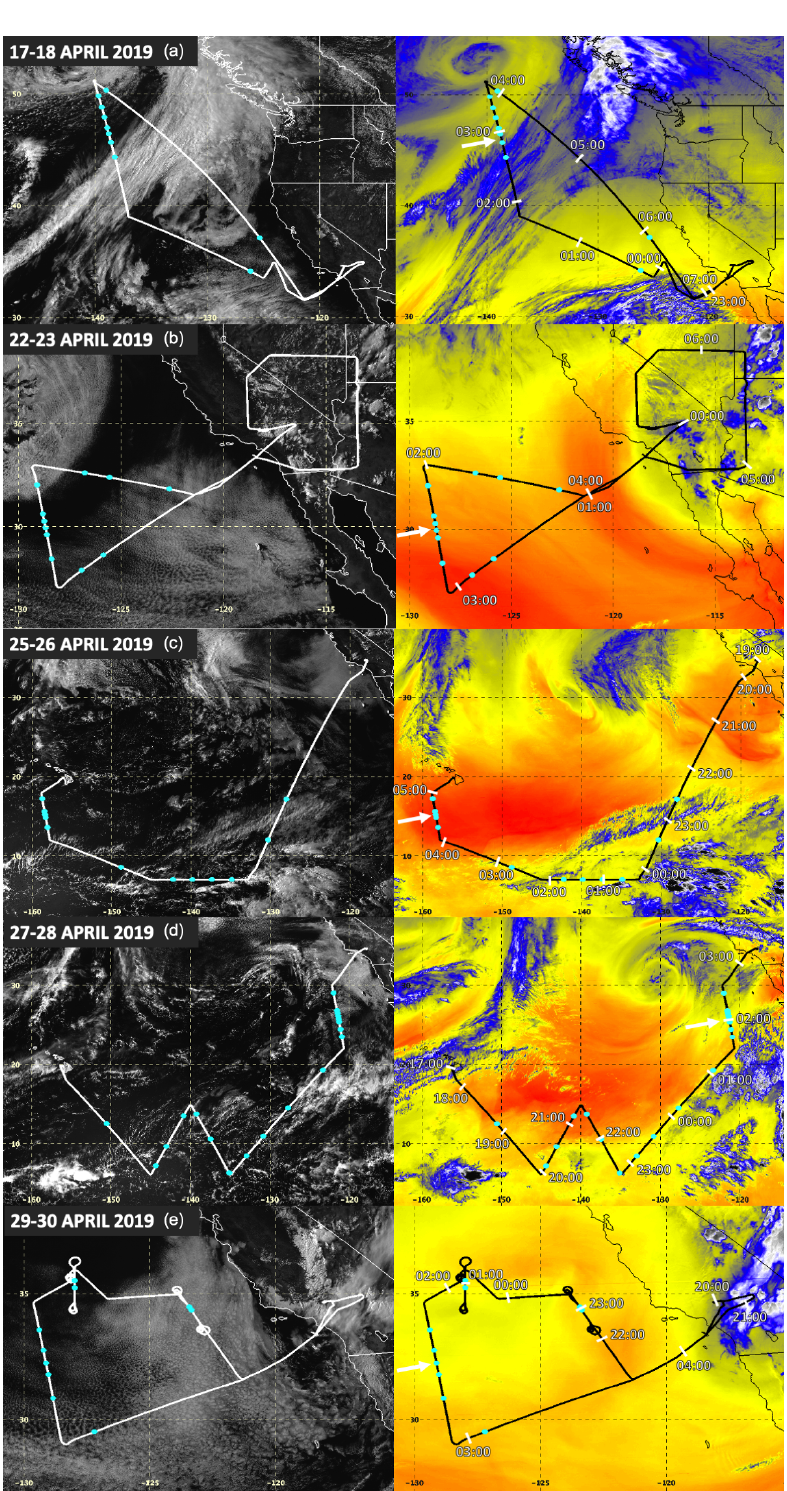
Figure 1. The DC-8 flight track (bold lines) overlain atop GOES-17 0.64µm visible (left) and 7.3µm water vapor brightness temperature (right, in kelvin) at (a) 00UTC on 18 April, (b) 00UTC on 23 April, (c) 0030UTC on 26 April, (d) 2230UTC on 27 April, and (e) UTC on 30 April. The DC-8 aircraft position at hourly intervals is annotated on the right panels. Cyan dots indicate where dropsondes were released. White arrows point to straight northwest–southeast-oriented segments, where the DC-8 underflew the Aeolus laser track at a 6km altitude for durations ranging from ∼ 45 to